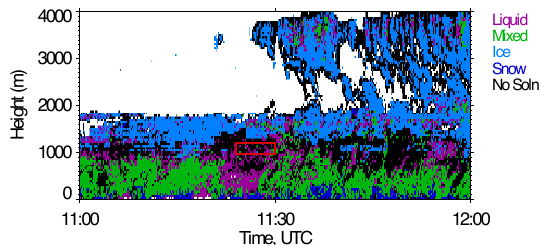
Figure 14. Phase identified by the 10-variable algorithm on 6 Oc- tober 2004, 11:00–12:00UTC; red box indicates region expected to be primarily drizzle based on study by Verlinde et al. (2013).